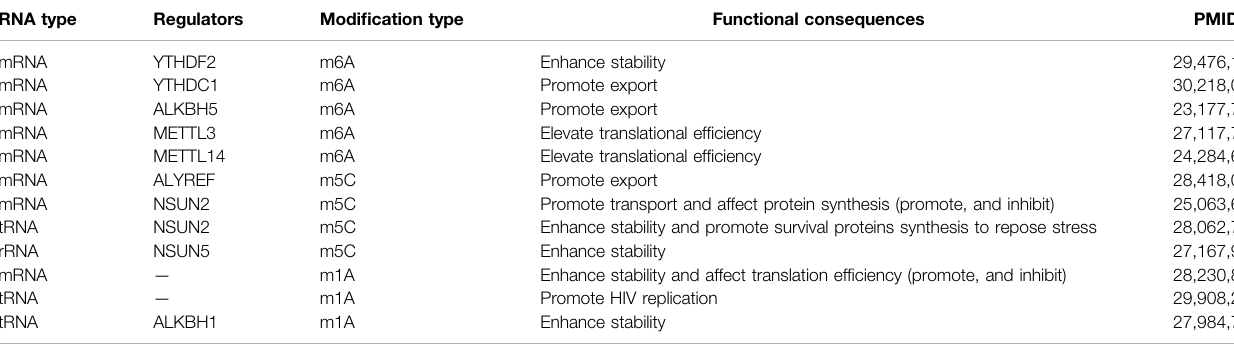
TABLE 1 | The modi fi cation results of m6A, m5C, and m1A methylation in various RNA. RNA